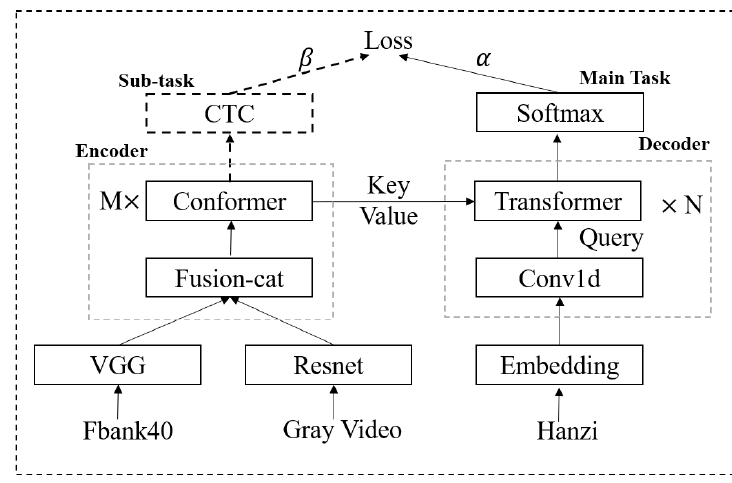
Figure 1. The illustration of the end-to-end AVSR baseline system.